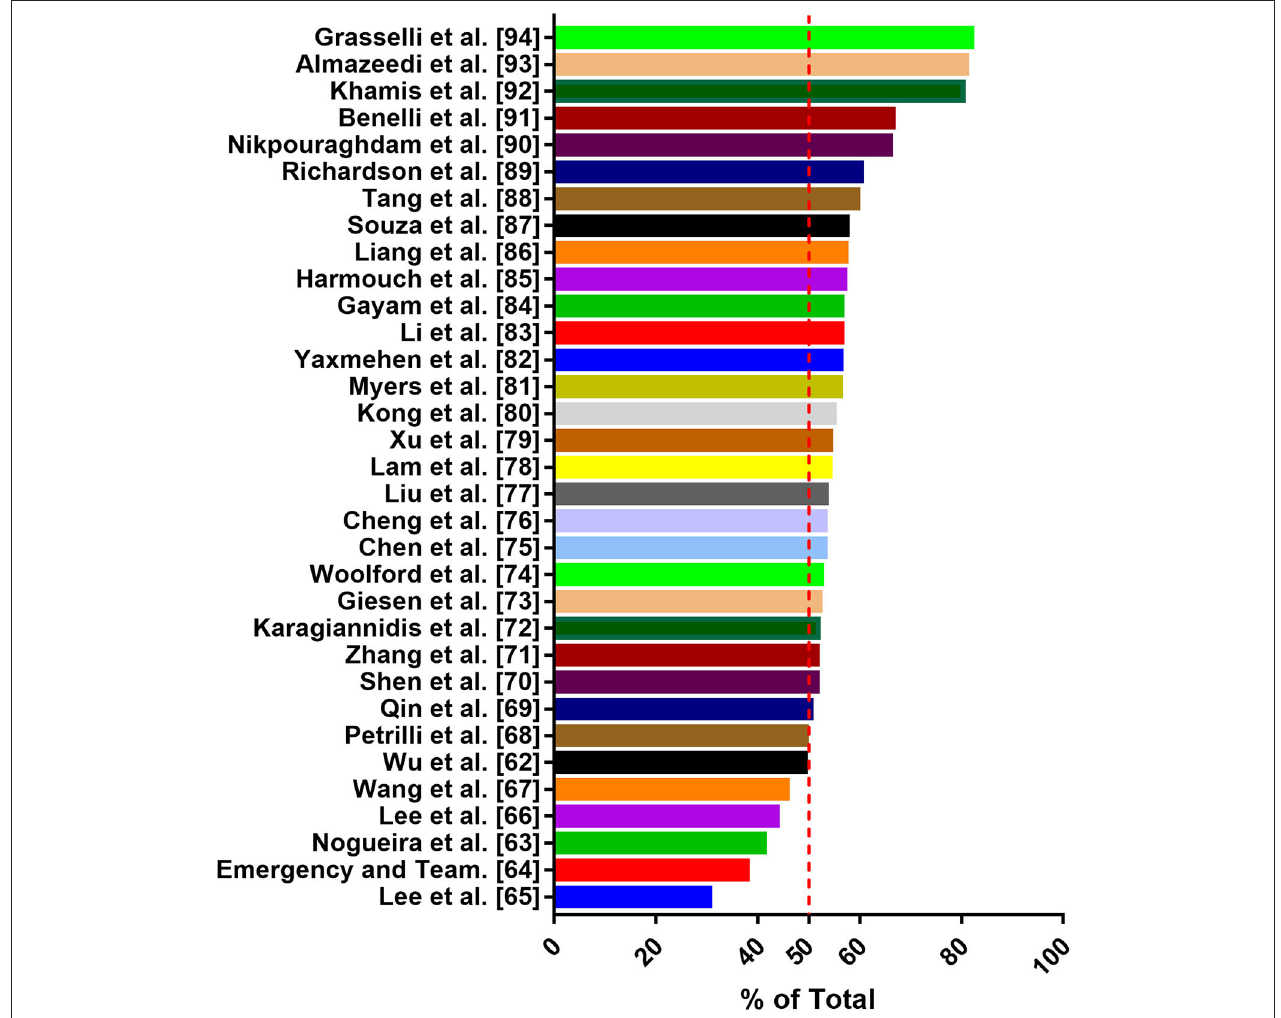
FIGURE 2 | Data on the proportion of males infected with SARS-CoV-2 from 33